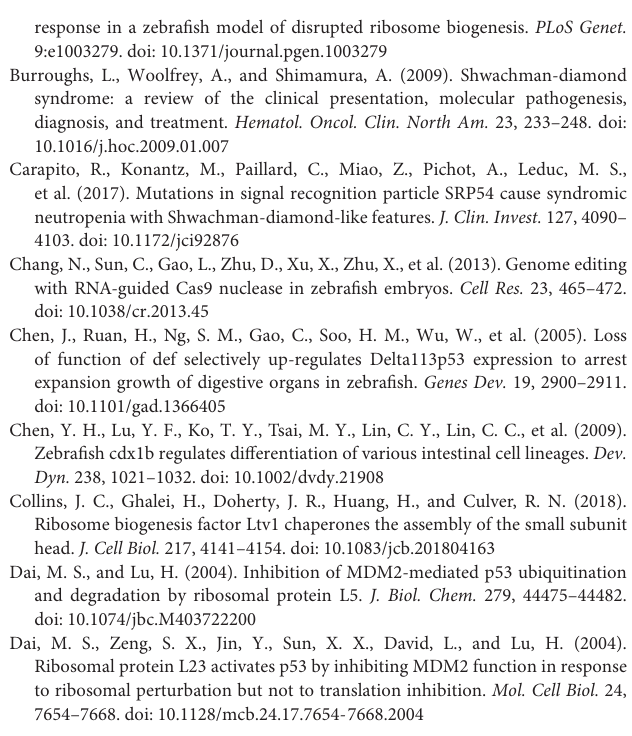
Supplementary Figure 2 | The liver bud growth and exocrine pancreas expansion are affected in ltv1 ∆ 14/ ∆ 14 mutant. (A–J) Embryos at 2 dpf, 34 hpf, and 30 hpf were subjected to WISH to analyze the liver and pancreas formation. The probes used include: pan-endodermal markers foxA1 , gata6 ; hepatic markers hhex , prox1 ; pancreas marker pdx1 ; endocrine pancreas markers gcga , insulin , and sst2 . (K) Representative confocal images of ltv1 ∆ 14/ ∆ 14 /ptf1a:gfp mutants and siblings at 2 dpf. (L) Quantification of ptf1a + cells of ltv1 ∆ 14/ ∆ 14 /ptf1a:gfp mutants and siblings at 2 dpf. Bars represent means with SD. White arrowhead: liver. Blue arrowhead: endocrine pancreas. Scale bar: 10 µ m. Supplementary Figure 3 | The primitive hematopoiesis is normal in ltv1 ∆ 14/ ∆ 14 mutant. (A,B) WISH of primitive hematopoiesis regulators gata1 (A) and pu.1 (B) at 20 and 22 hpf, respectively. Supplementary Figure 4 | The defects of HSPC is observable at 3 dpf. (A) WISH of c-myb in the CHT at 2 dpf. (B) Quantification of c-myb + HSPCs in the CHT of ltv1 ∆ 14/ ∆ 14 mutants and siblings at 2 dpf. (C) ltv1 ∆ 14/ ∆ 14 mutants displayed significantly decreased c-myb expression in the CHT at 3 dpf compared with the siblings. Supplementary Figure 5 | The mutant phenotypes can be rescued by zebrafish ltv1 mRNA injection. (A,C) Representative images of fabp10 or c-myb expression of unrescued and partially and fully rescued mutants after the injection of zebrafish wild-type ltv1 mRNA. (B,D) The rescue efficiency of the liver or HSPC phenotypes in mutants after the injection of zebrafish wild-type or (cid:49) 14 ltv1 mRNA ( N ≥ 30 in every group). Bars represent means with SD. Supplementary Figure 6 | Apoptotic level of the exocrine pancreas and HSPCs are not increased in ltv1 ∆ 14/ ∆ 14 mutant. (A) No apoptotic cells are found in the pancreas region in cryosectioned samples from both ltv1 ∆ 14/ ∆ 14 mutants and siblings at 3 dpf. (B) Representative confocal images of the ltv1 ∆ 14/ ∆ 14 /runx1:en-gfp mutants and siblings after TUNEL assay at 2.5 dpf. (C) Ratio of apoptotic cells in runx1 + HSPCs in ltv1 ∆ 14/ ∆ 14 mutants ( N = 6) and siblings ( N = 6) at 2.5 dpf. Bars represent means with SD. White arrow: merged cell. Scale bar: 10 µ